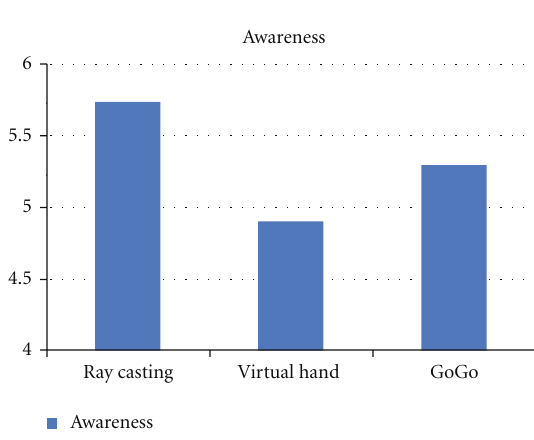
Figure 8: Mean di ff erence in the involvement.